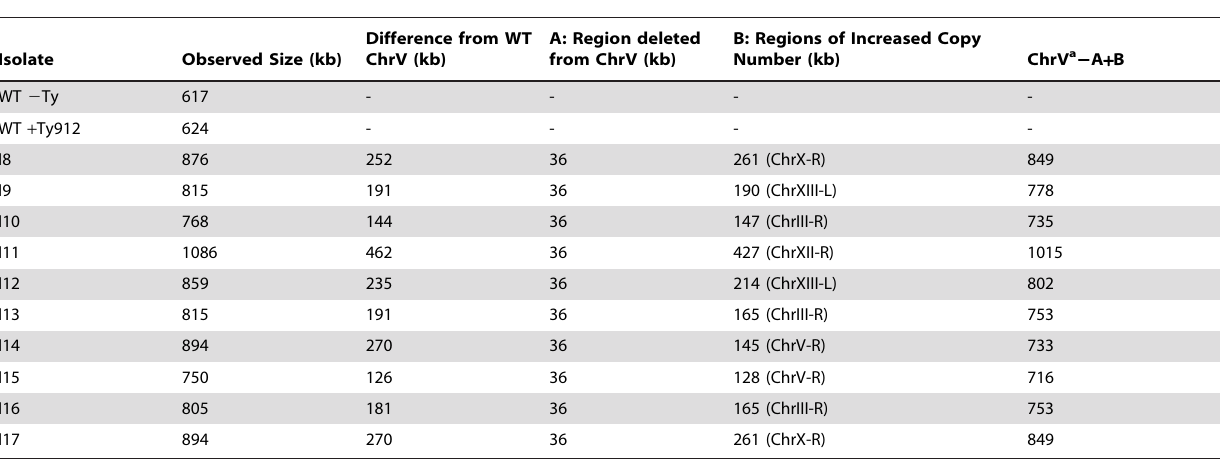
Table 3. Observed and predicted Chr Vs from a Southern blot of isolates I8–I17.